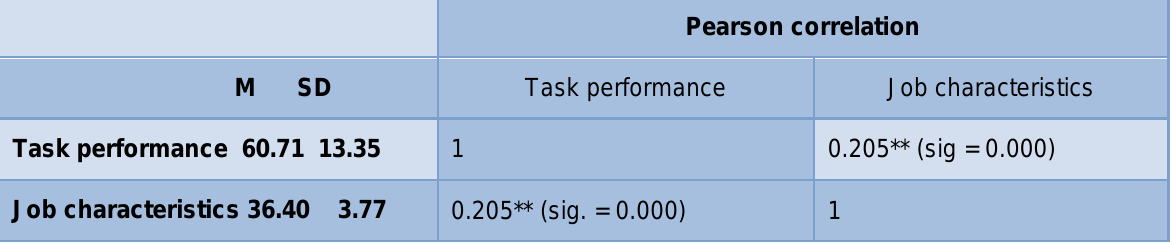
Table 2 Association between overall Job characteristics and overall Task performance ** Correlation is significant at 0.01 level (2 - tailed), M = Mean, SD = Standard